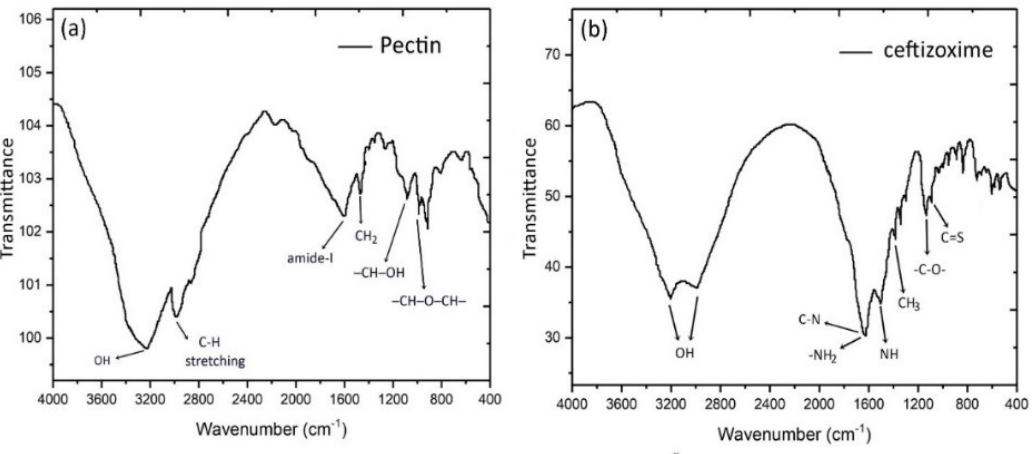
Nanomaterials 2020 , 10 , 1452 Figure 3. FTIR spectra of pectin ( a ) and ceftizoxime ( b ). Figure 3. FTIR spectra of pectin ( a ) and ceftizoxime ( b ).